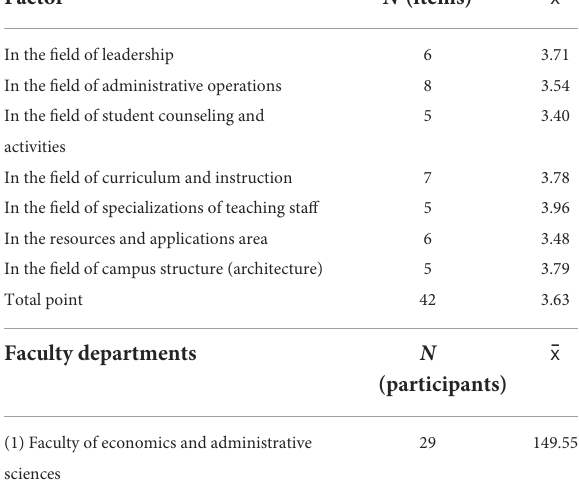
TABLE 1 The arithmetic mean of the whole scale and its sub-dimensions, and the total score distribution of the faculty units.